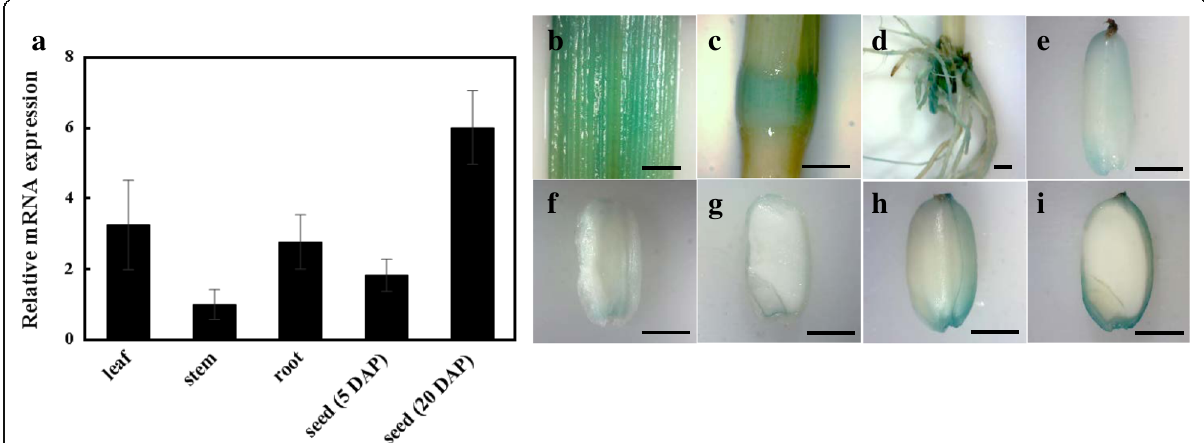
Fig. 6 Tissue-specific RNA expression pattern of LE . a qRT-PCR analysis of LE gene in leaf, stem, root and seed (5 and 20 DAP). b-i GUS expression pattern of various tissues in Pro LE : GUS transgenic line [leaf ( b ); stem ( c ); root ( d ); seed at 5 DAP ( e ); seed at 10 DAP ( f and g ); seed at 20 DAP ( h and i )]. Error bars indicate ± s.d. of replicates. Scale bars = 2